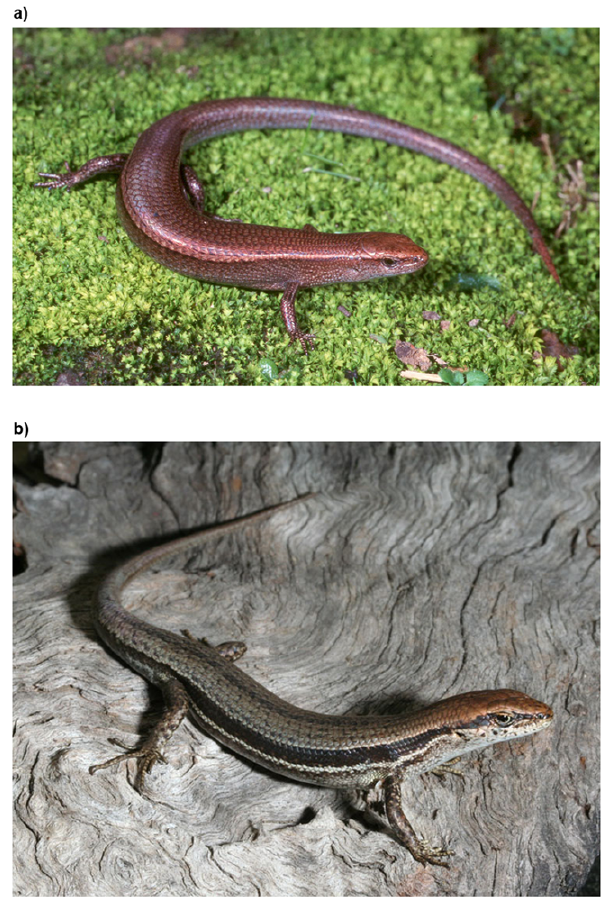
Figure 1. The two study species: a) delicate skink ( Lampropholis delicata ), and b) garden skink ( Lampropholisguichenoti ). Photo- graphs: Nick Clemann.